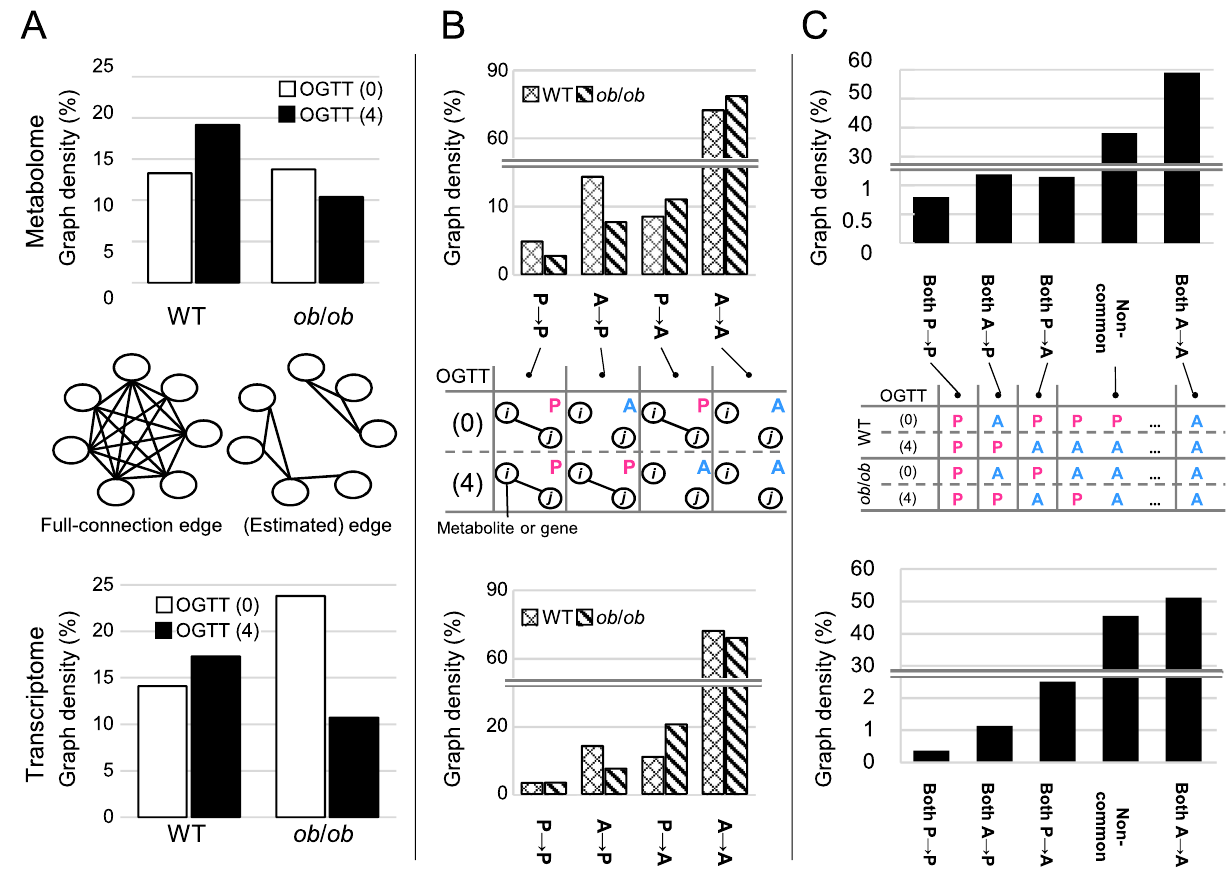
Figure 3. The edge amount quantification of each network. The graph density in each condition; ( A ) the graph density of the OGTT response network; ( B ) the comparison of the graph density of the OGTT response network between WT and ob / ob ; ( C ) the graph density in the metabolome (upper panel) and transcriptome (lower panel). The middle panel in ( A – C ) are supplementary schematic diagrams that helps to interpret each graph. ( A ) The graph density of the OGTT (0) and OGTT (4) networks in WT and ob / ob . ( B ) The changes in the presence and absence of edges between the OGTT (0) and OGTT (4). “P → P,” “A → P,” “P → A,” and “A → A” stand for the edges, which are common to the OGTT (0) and OGTT (4) networks, the edges only existing in the OGTT (4) network, the edges only existing in the OGTT (0) network and the edges existing in neither OGTT (0) nor OGTT (4) networks, respectively. ( C ) The comparison between WT and ob / ob in the graph density of each edge explained in figure ( B